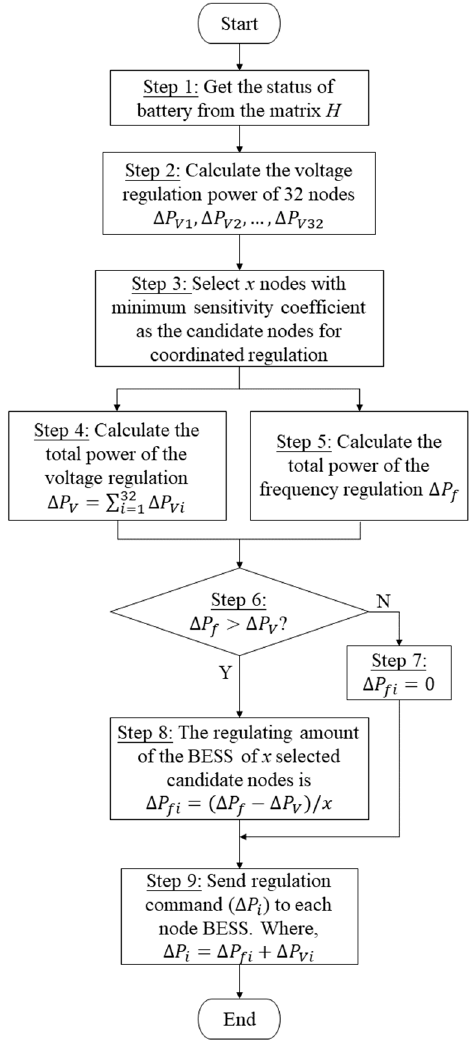
Figure 6. Battery energy storage systems (BESS) coordination control algorithm flow chat.